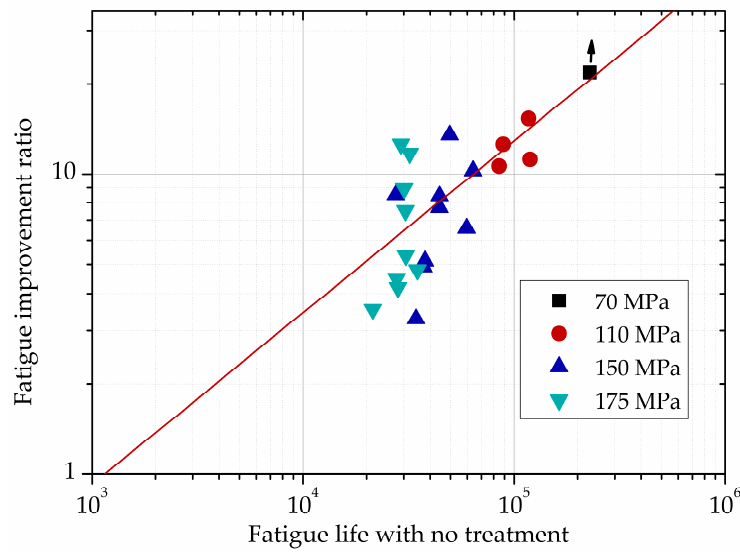
Figure 8. Ratio of fatigue life in specimens with shot peening over life in specimens without shot peening for different values of bulk stress.